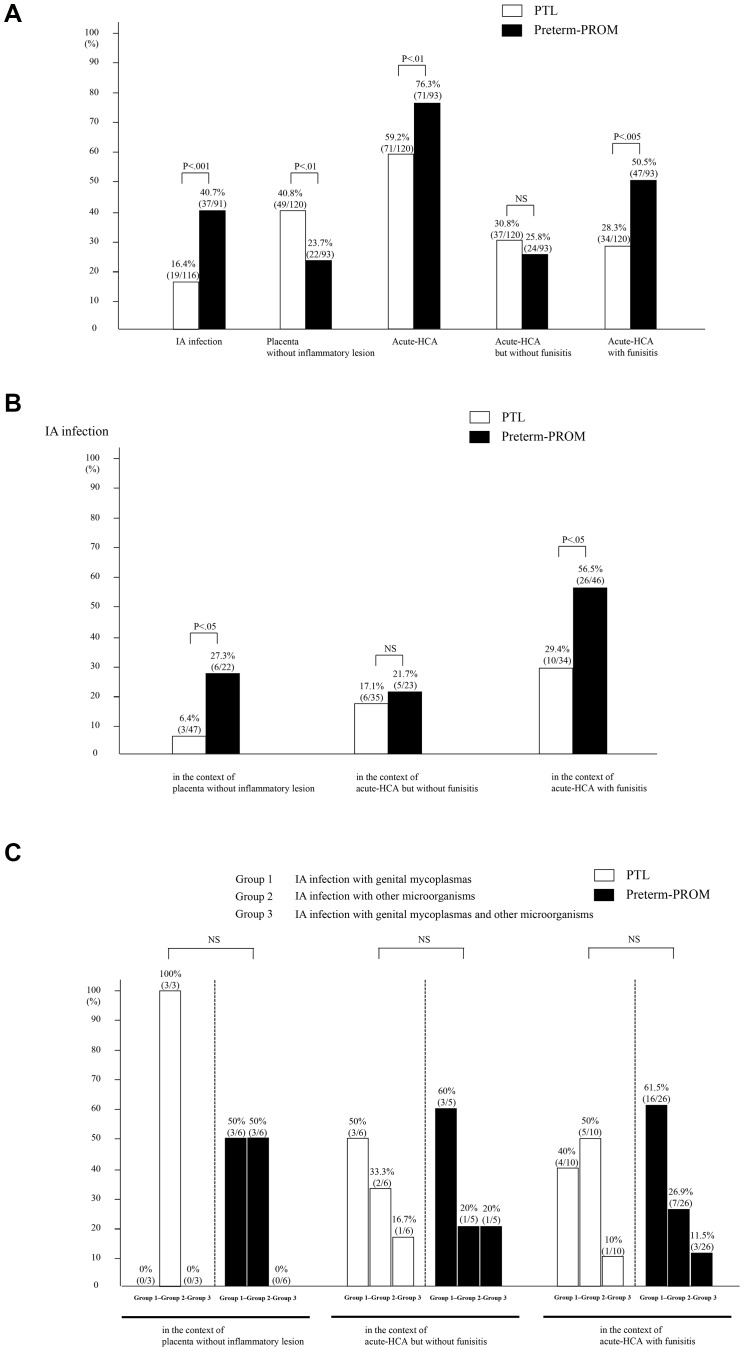
(a) The frequency of intra-amniotic (IA) infection and each placental inflammatory condition (i.e. placenta without inflammatory lesion, acute histologic chorioamnionitis (acute-HCA), acute-HCA but without funisitis, and acute-HCA with funisitis) according to preterm labor and intact membranes (PTL) or preterm premature rupture of membranes (preterm-PROM),(b) the frequency of IA infection according to PTL or preterm-PROM, in the context of the presence or absence of acute-HCA with or without funisitis (each and all frequency or P value is shown in graphs), and (c) the frequency of types of microorganisms isolated from amniotic fluid in patients with IA infection according to PTL or preterm-PROM, in the same context of placental inflammatory condition (i.e. placenta without inflammatory lesion, acute-HCA but without funisitis and acute-HCA with funisitis).